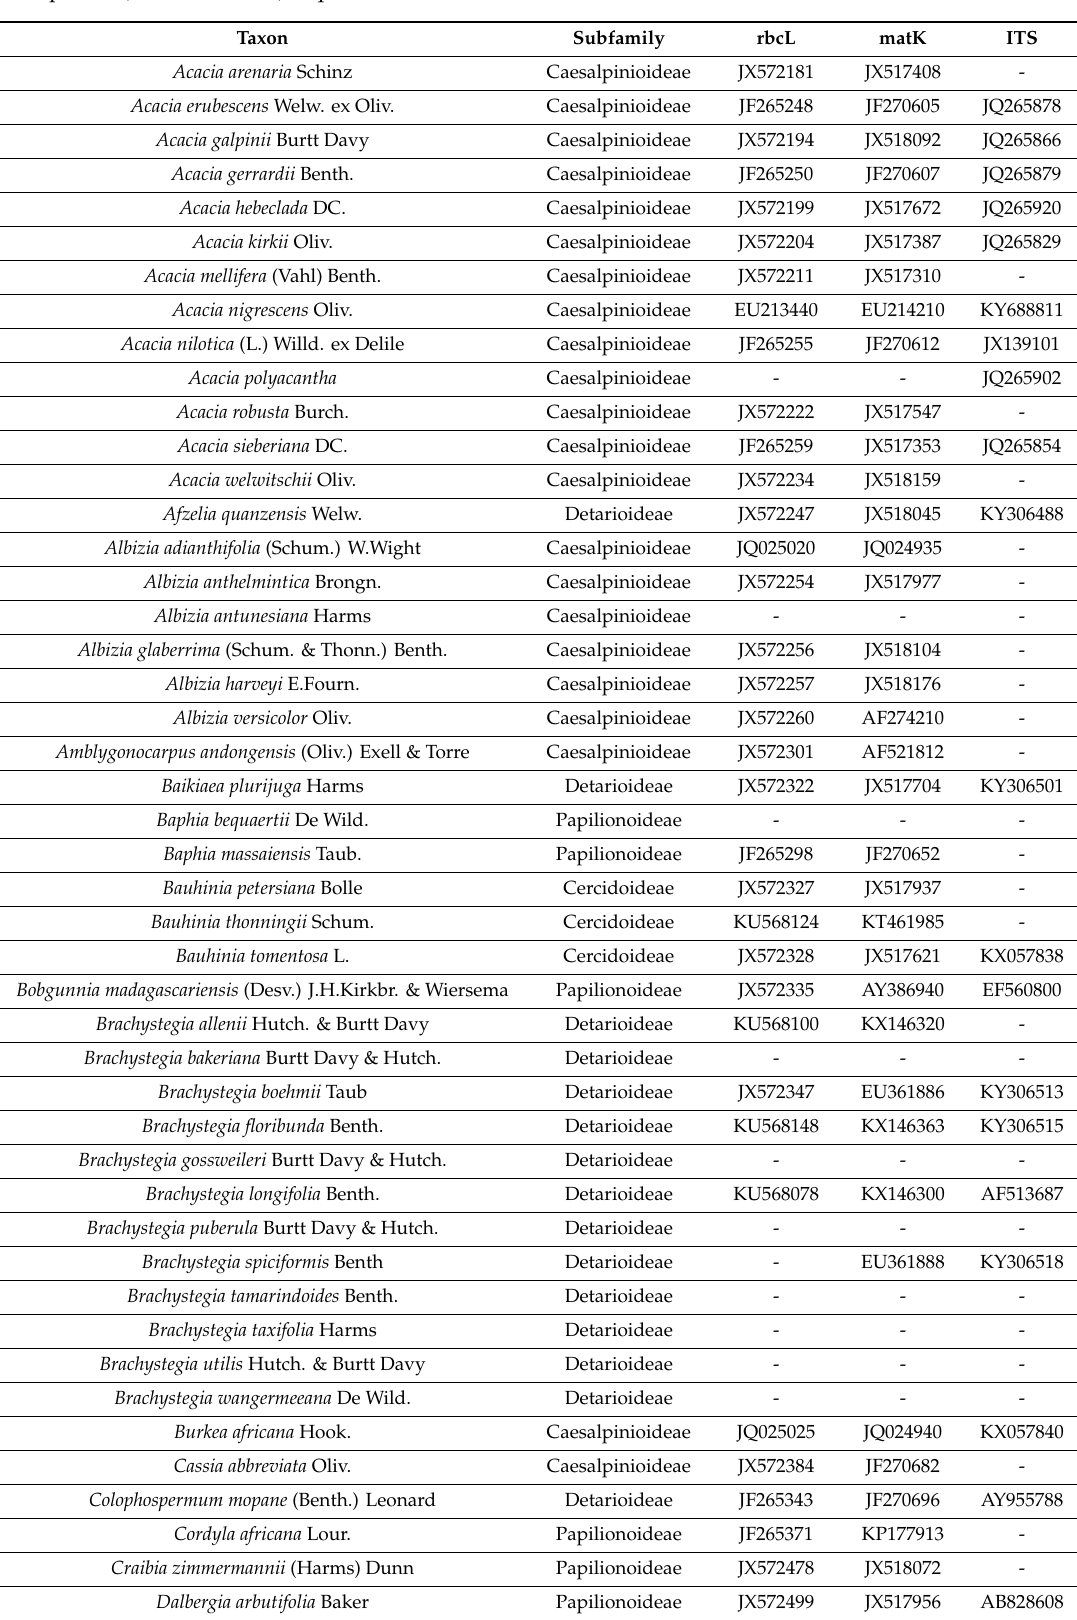
Table 2. Leguminosae tree species from Miombo and Mopane ecosystems used in the phylogenetic analyses. GenBank accession numbers for the corresponding internal transcribed spacer (ITS) and cpDNA (rbcL and matK)